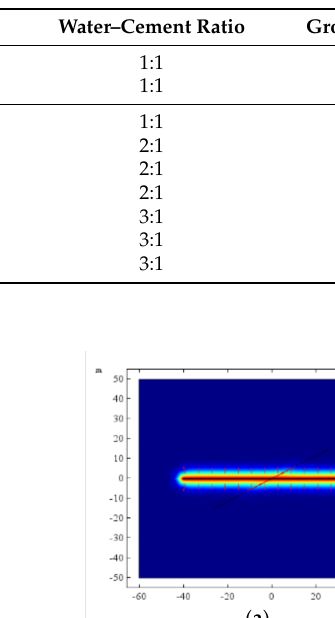
Table 9. Numerical simulation working conditions.